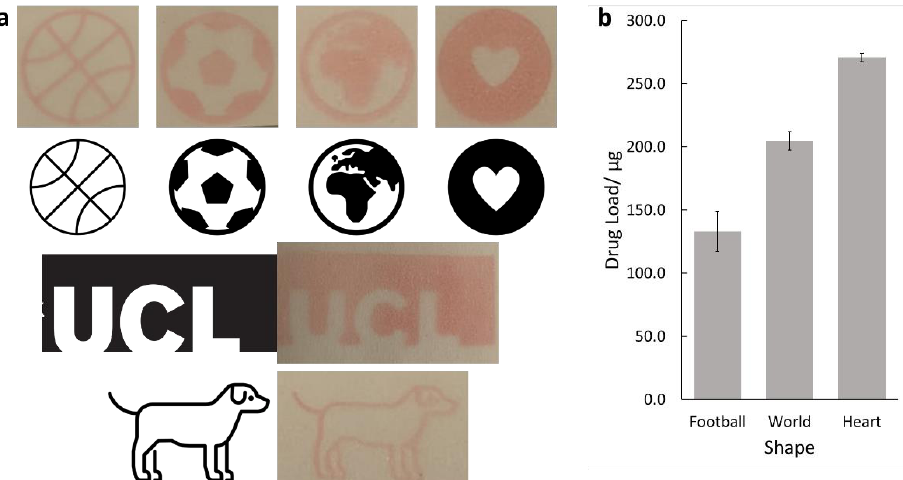
Figure 4. ( a ) Images of the selected black and white shapes and photographs of the printed shapes. The images selected were a basketball, a football, a world, a heart, the University College London logo and a cartoon dog. ( b ) The drug load for the football, world and heart shapes. All three show high levels of drug loading, with the heart showing the highest.